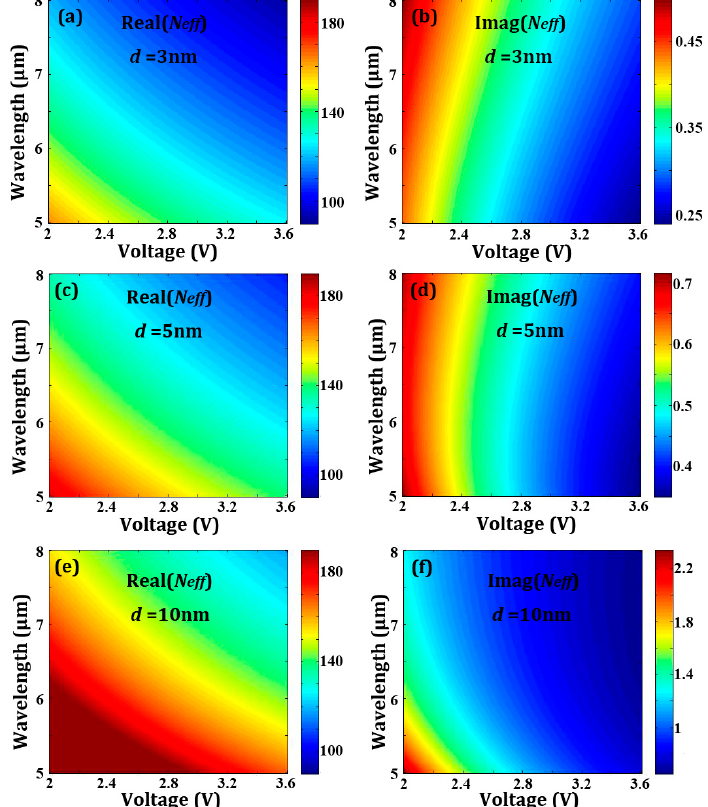
Figure 2. ( a , c , e ) The real part and ( b , d , f ) the imaginary part of the effective reflective index of graphene Neff as a function of applied voltage V and wavelength λ for d = 3 nm, d = 5 nm, and d = 10 nm. Here, the carrier mobility is μ = 2 m 2 ·V − 1 ·s − 1 .